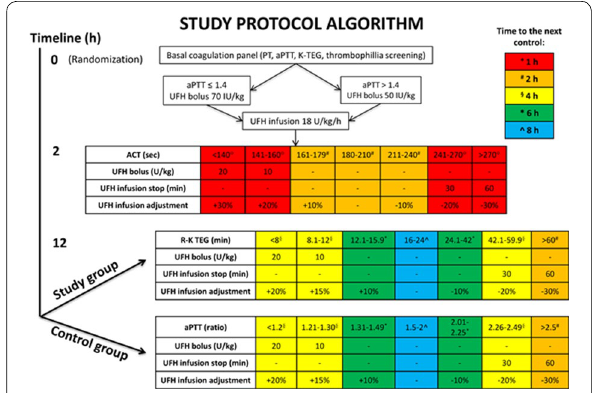
Fig. 1 During the first 12 h after ECMO cannulation, the algorithm was identical in the two study groups. After the first 12 h according to randomization, the anticoagulation management was modified according to the assigned study group: In the TEG group (interven- tion group), heparin infusion was titrated to reach a target TEG-K reaction time (R-K) of 16–24 min (normal values: 4–8 min); in the aPTT group (standard of care–control group), heparin infusion was titrated to reach a target aPTT ratio value of 1.5–2. Under-target levels of anti- coagulation were corrected with either heparin bolus plus increase in infusion or with increase in infusion only; similarly, over-target levels of anticoagulation were corrected with either heparin infusion stop for 30 or 60 min and restart with a reduced dose or with decrease in infusion only. Time to the next control varied according to the degree of derangement from target values of anticoagulation. In case of sur- gery, minimal levels of anticoagulation (i.e., R-K of 8–12 min and aPTT ratio of 1.2–1.3, in the study and control group, respectively) were tolerated during the first 24 h after the operation. In case of bleeding, heparin infusion was reduced to the lower value of the target range or interrupted based on the severity of